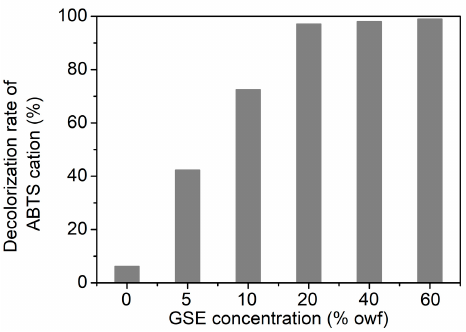
Figure 7. Antioxidant activity of cotton fabrics dyed with GSE at various concentrations.